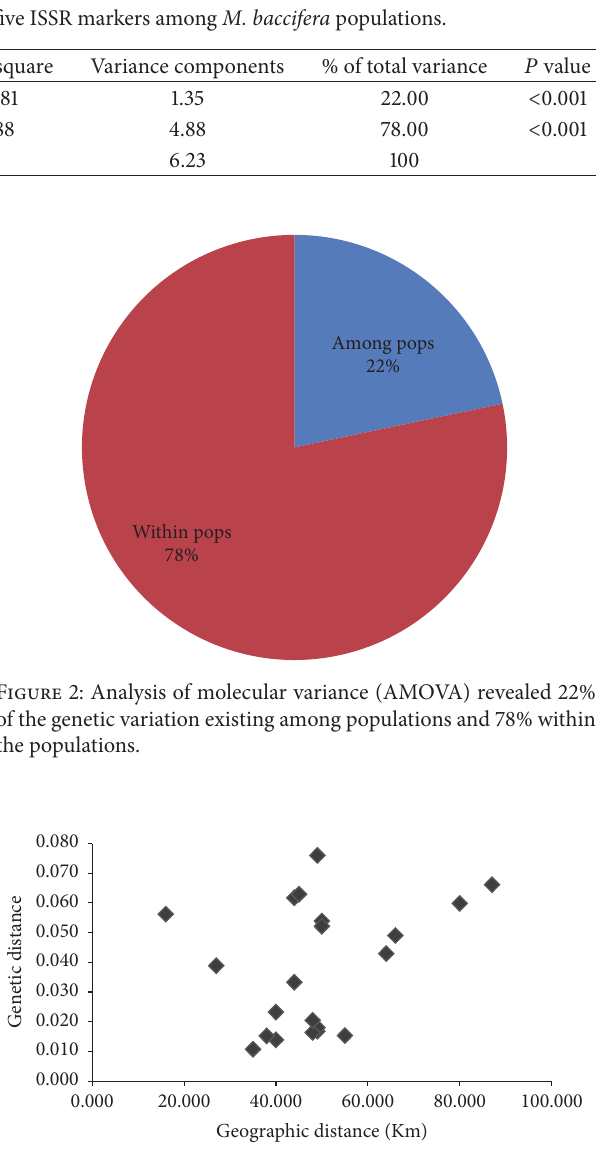
Figure 3: Correlation between genetic and geographic distance among 7 populations of M.